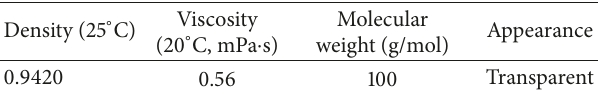
Table 2: Properties of MMA monomer.